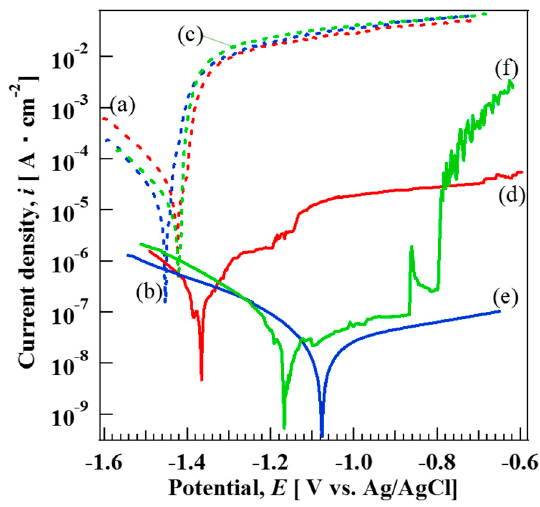
Figure 6. Potentiodynamic polarization curves of bare (a) AZ31, (b) AZ61, and (c) AZ91D and film-coated (d) AZ31, (e) AZ61, and (f) AZ91D in 5 mass% NaCl aqueous solution. Table 3. Corrosion potential ( E corr ) and corrosion current density ( i corr ) of the films prepared at 423 K for 5 h on AZ31, AZ61, and AZ91D Mg alloys and bare AZ31, AZ61, and AZ91D Mg alloys obtained by Tafel